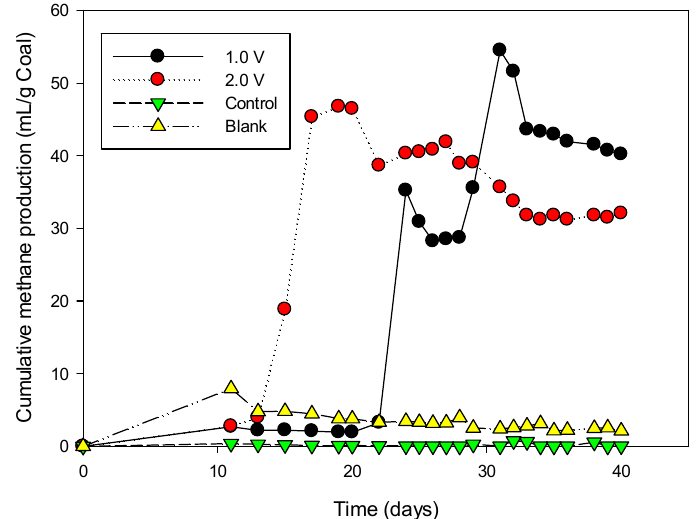
Figure 2. Cumulative methane production in bioelectrochemical anaerobic reactor.